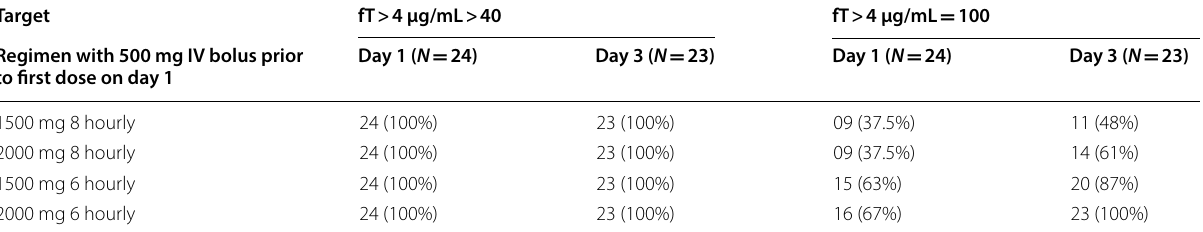
fT > 4 μg/mL > X: plasma meropenem concentration exceeds 4 μg/mL for more than X% of the dosing interval